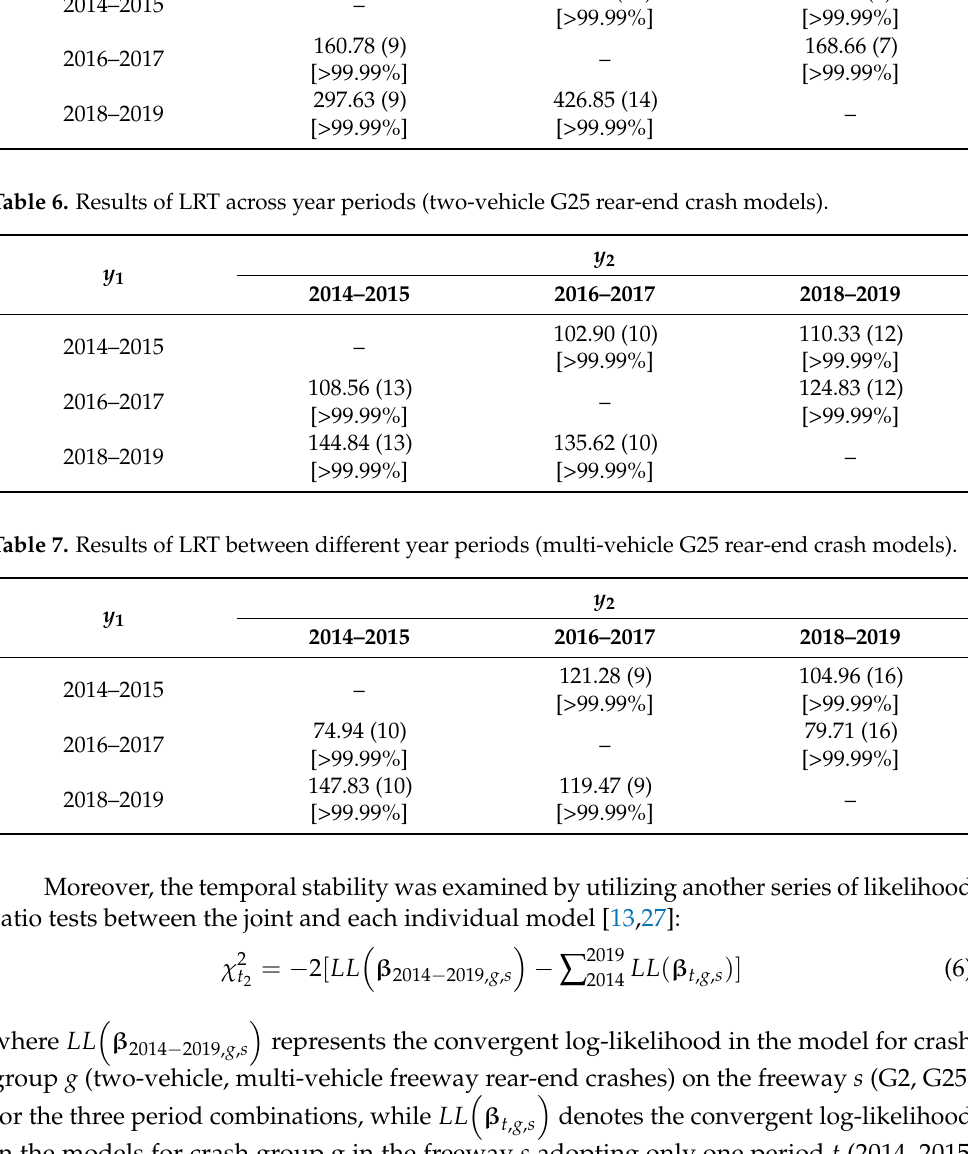
Table 5. Results of LRT across year periods (multi-vehicle G2 rear-end crash models). y 1